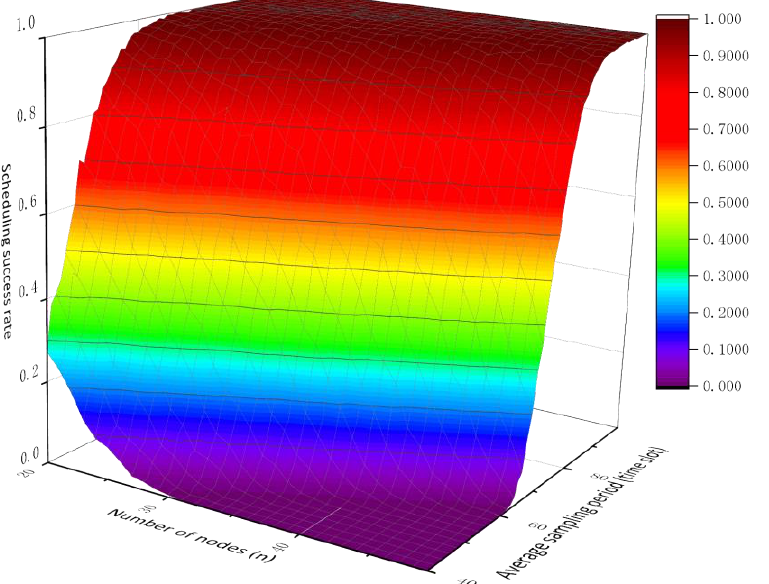
Figure 8. Schedulability analysis with respect to varying numbers of nodes and sampling periods.